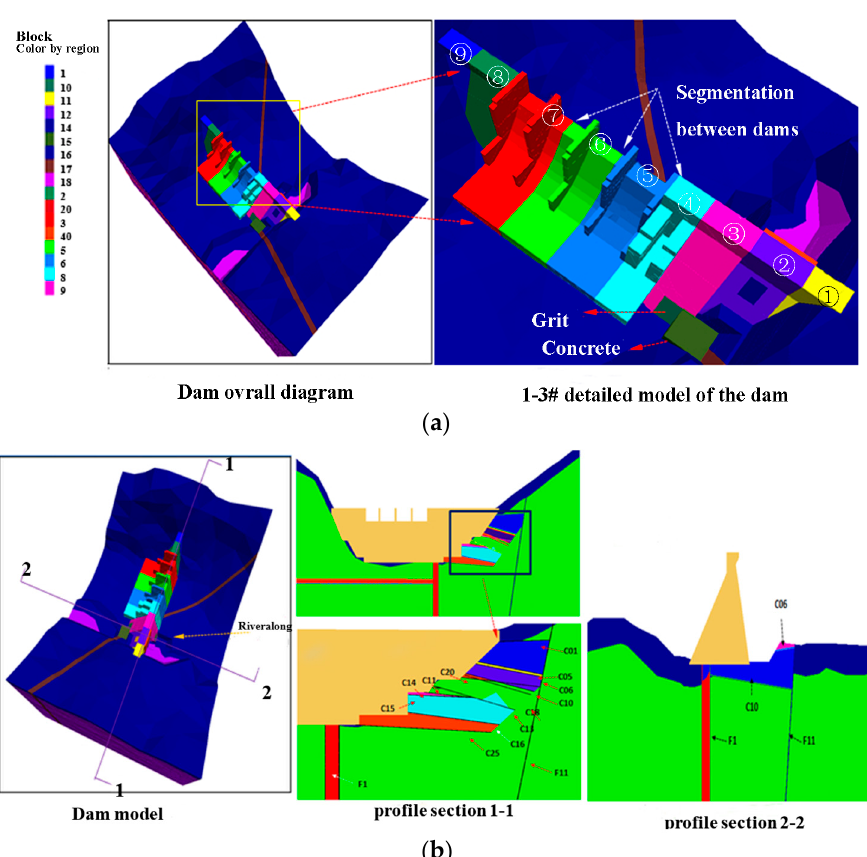
Figure 3. ( a ) Three-dimensional (3D) model of dam at Capulin San Pablo power station ( b ) Model profile of the Capulin San Pablo dam.